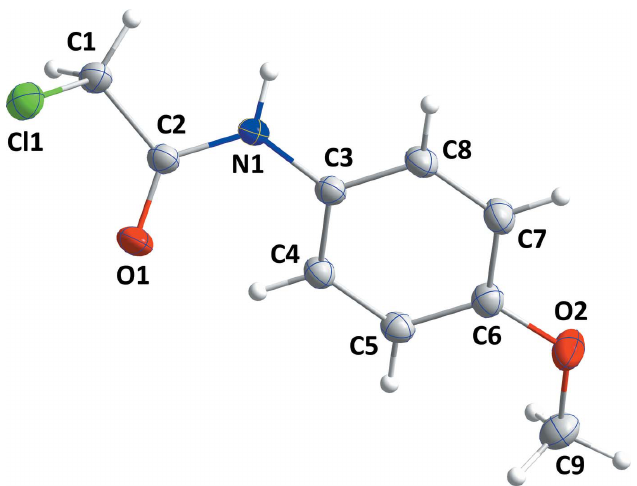
Figure 1 The molecular structure of the title molecule with labelling scheme and 50% probability